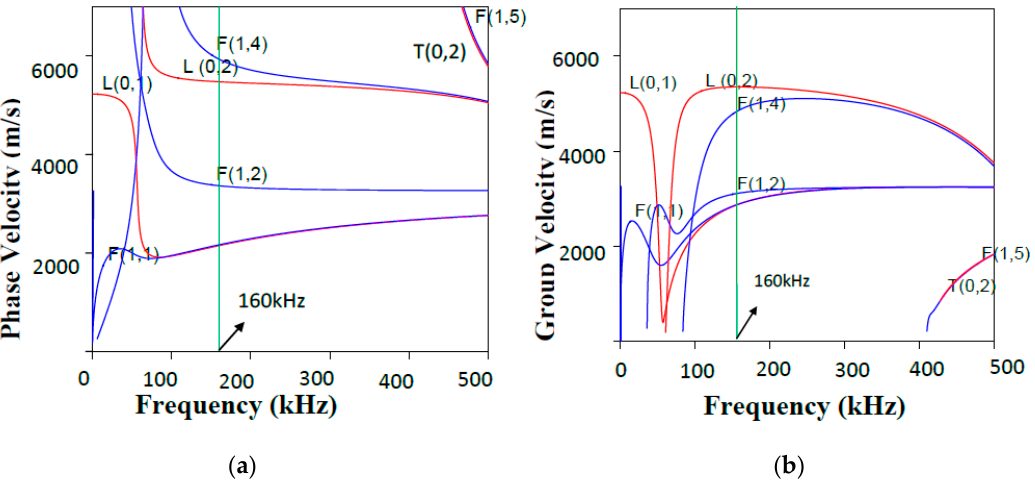
Figure 4. Phase ( a ); and group ( b ) velocity dispersion curves of the examined pipe.